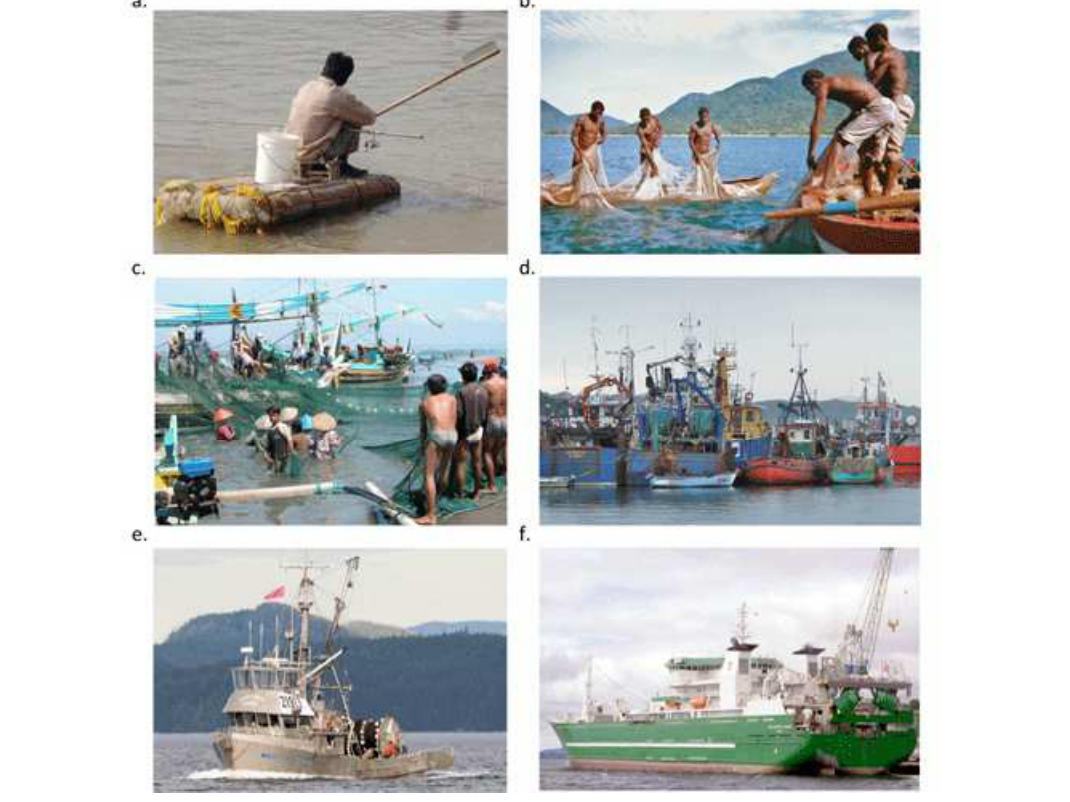
Fig. 1 . From Local Fishermen to Global Fishing